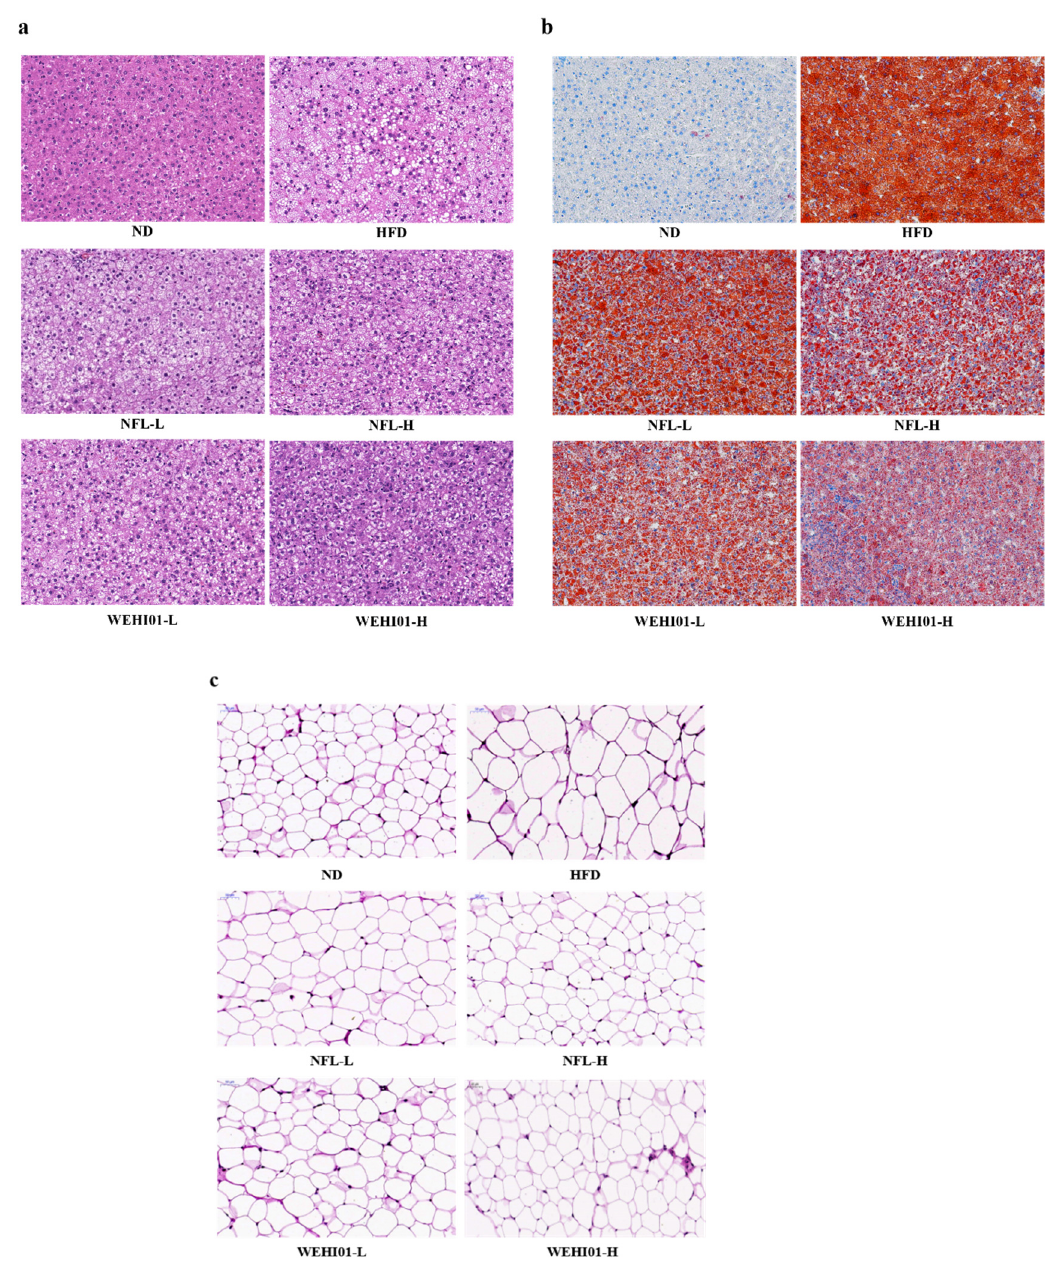
Figure 7. Effect of FLLS-WEHI01 on liver and epididymal tissue in obese rats. ( a ) H&E staining of liver. ( b ) Oil Red O staining of liver. ( c ) H&E staining of white adipose tissue of epididymis. Values were expressed as mean ± SD ( n = 3).